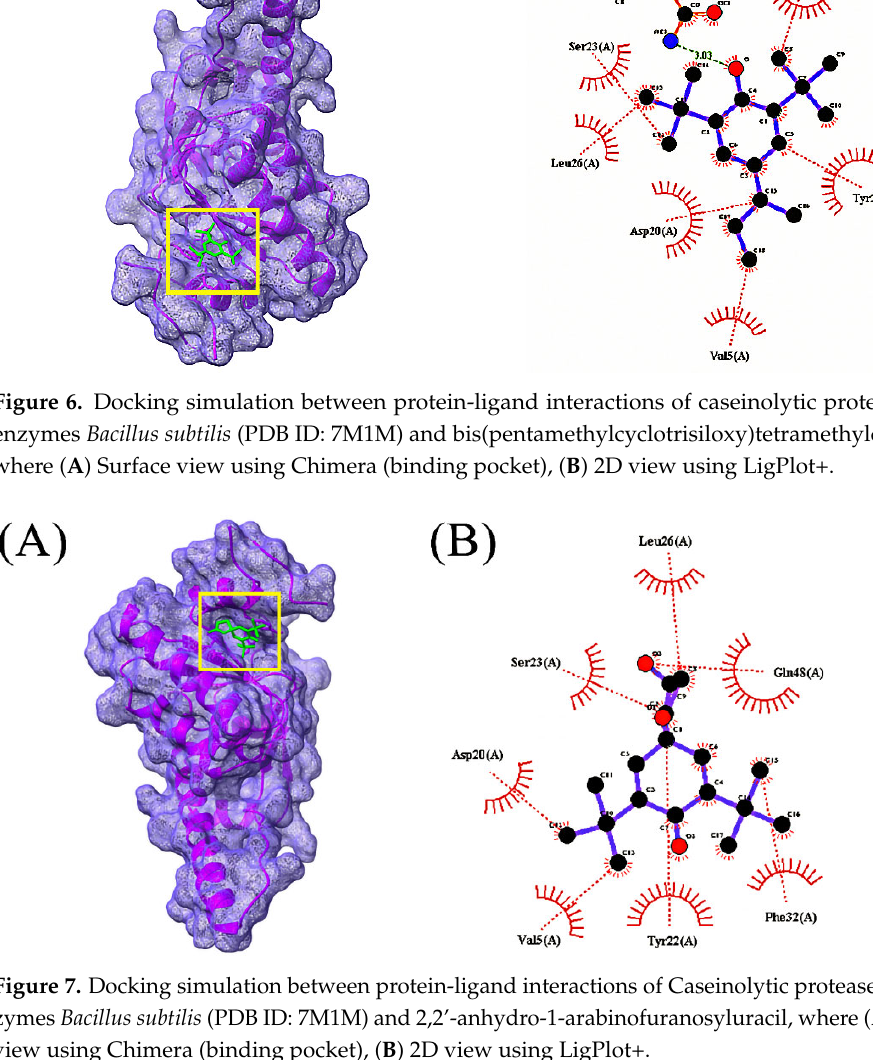
Surface view using Chimera (binding pocket), ( B ) 2D view using LigPlot+.